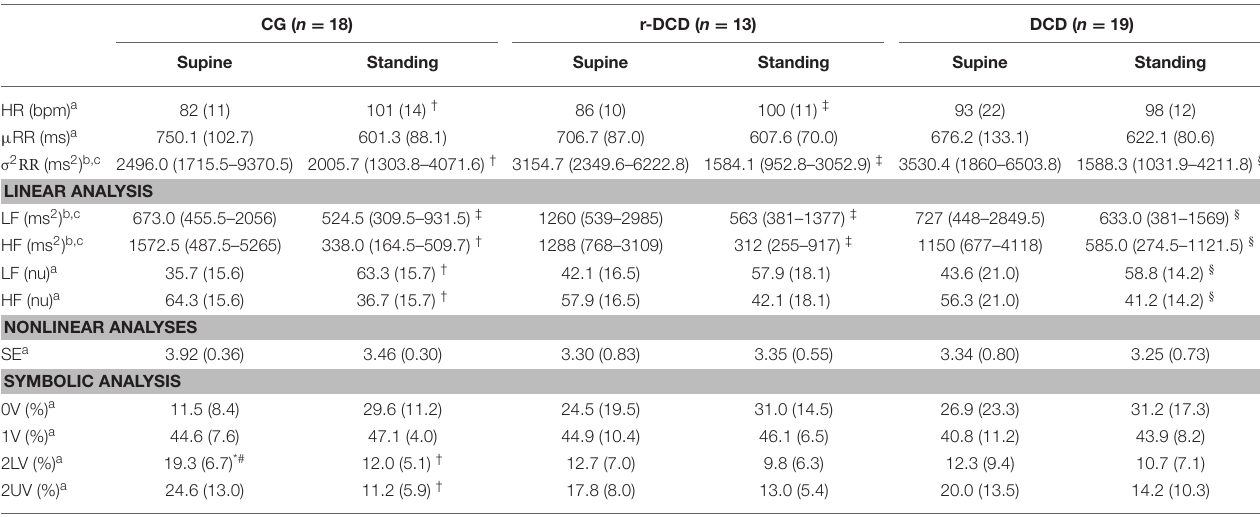
TABLE 3 | Linear and nonlinear heart rate variability indices from children with typical development (CG), children at risk for Developmental Coordination Disorder (r-DCD) and those with DCD. CG ( n = 18) r-DCD ( n = 13) DCD ( n = 19) Standing Supine Standing Supine